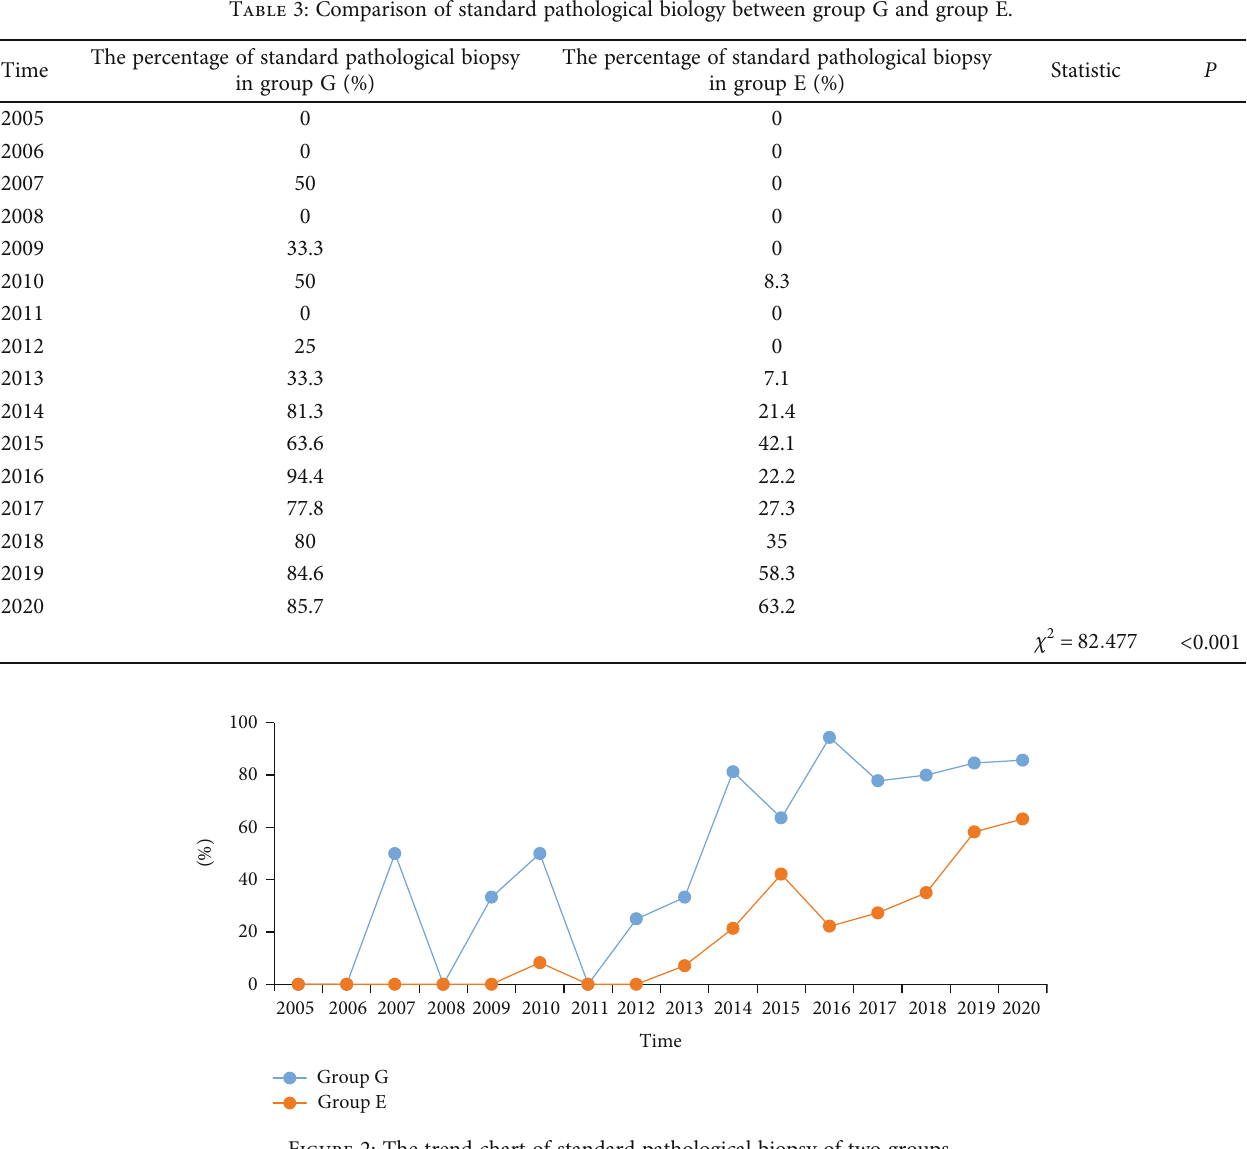
Figure 2: The trend chart of standard pathological biopsy of two groups.